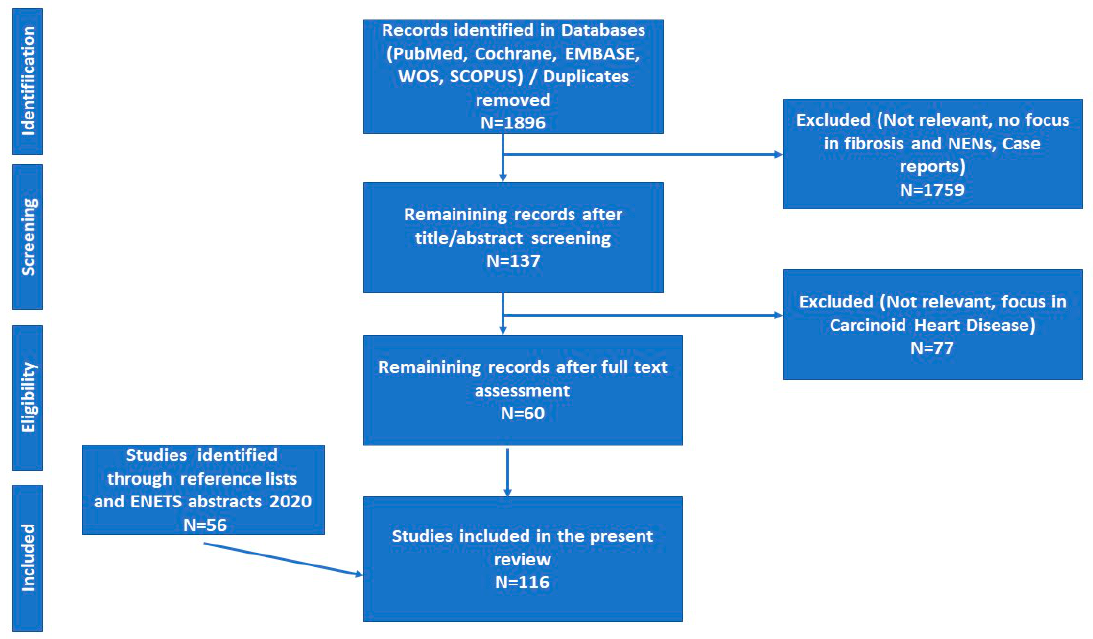
Figure 1. Preferred Reporting Items for Systematic Reviews and Meta-Analyses (PRISMA) flow diagram of study selection. Abbreviations: ENETS; European Neuroendocrine Tumor Society; NENs: Neuroendocrine Neoplasms.